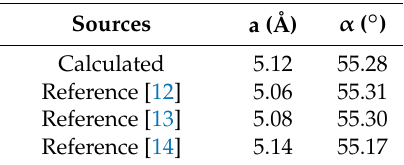
Table 1. The calculated lattice parameters and theoretical values.